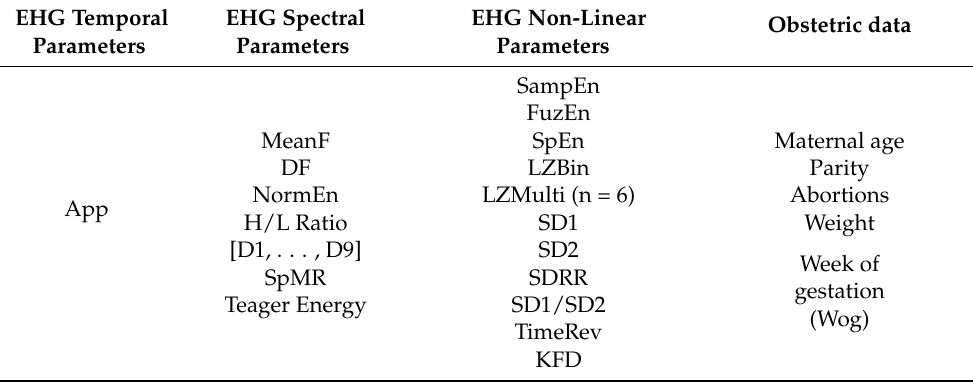
Table 2. Input features for predicting preterm labor that including both temporal,spectral and non-Linear EHG parameters and obstetric